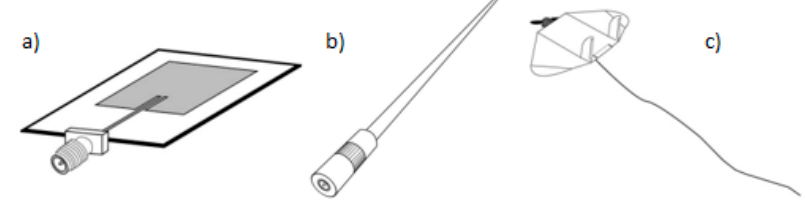
Figure 2. ( a ) Planar antenna [4]; ( b ) whip-monopole antenna [4]; ( c ) dragged-wire Antenna [4].